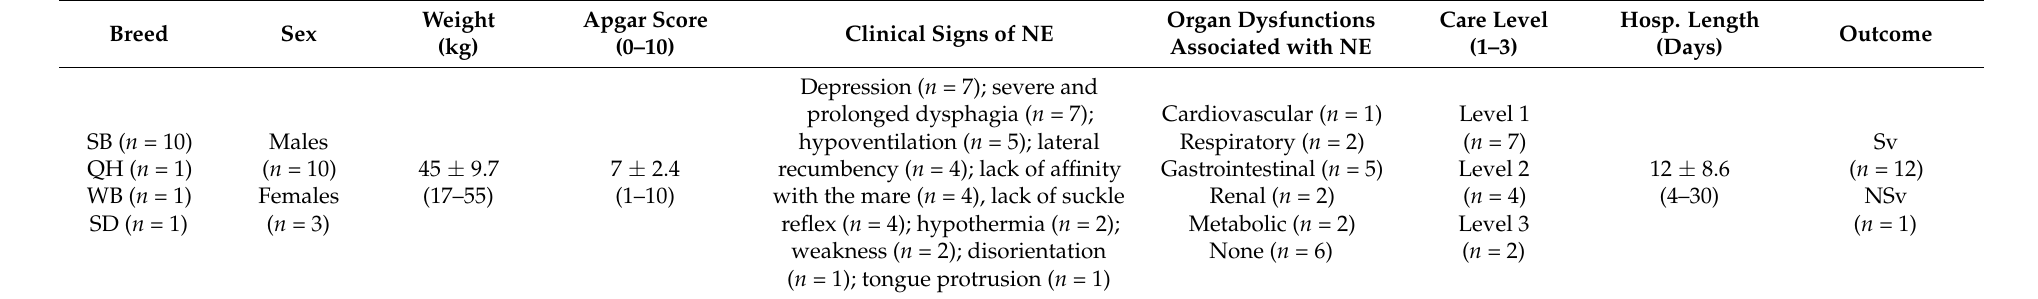
Table 3. Clinical data collected from 13 foals affected by Neonatal Encephalopathy born from attended parturition (group NE). SB = Standardbred; QH = Quarter Horse; WB = Warmblood; SD = Saddlebred; Sv = survived to hospital discharge; NSv = not survived; n = number of animals. Data are expressed as mean ± standard deviation (min-max).